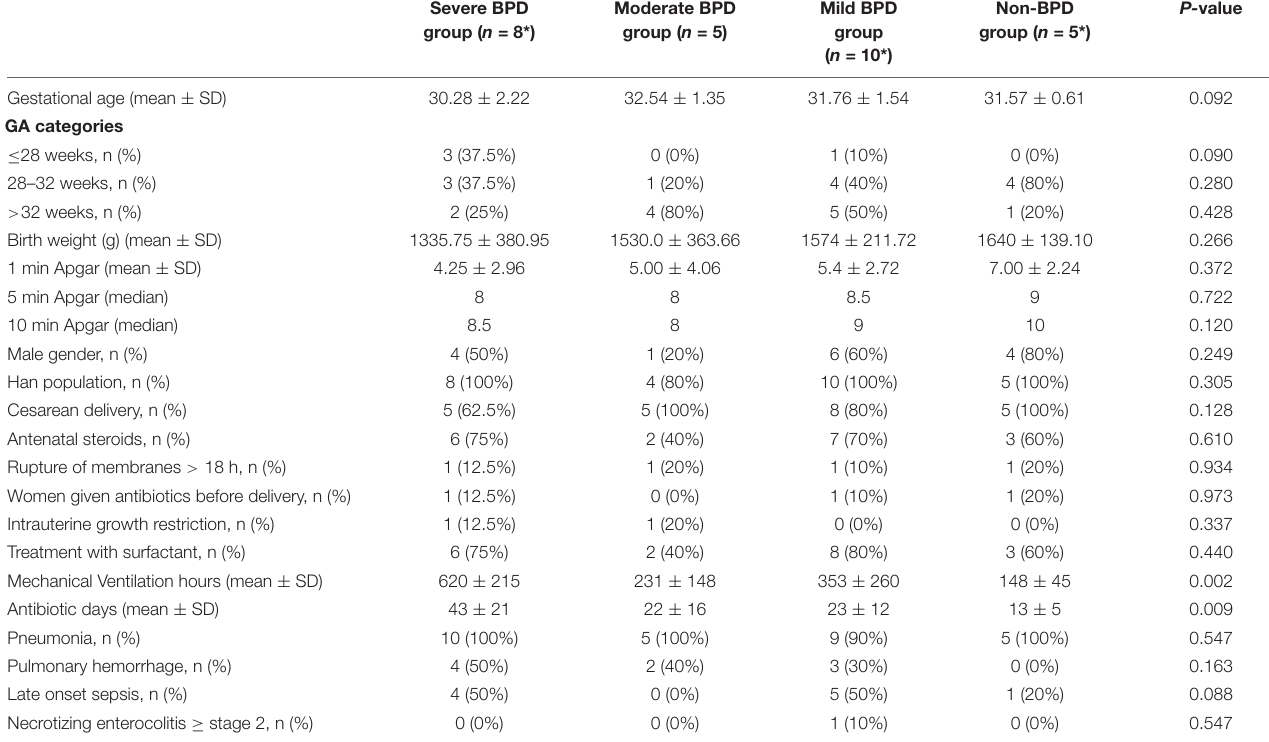
TABLE 1 | Demographic and clinical characteristics of the included